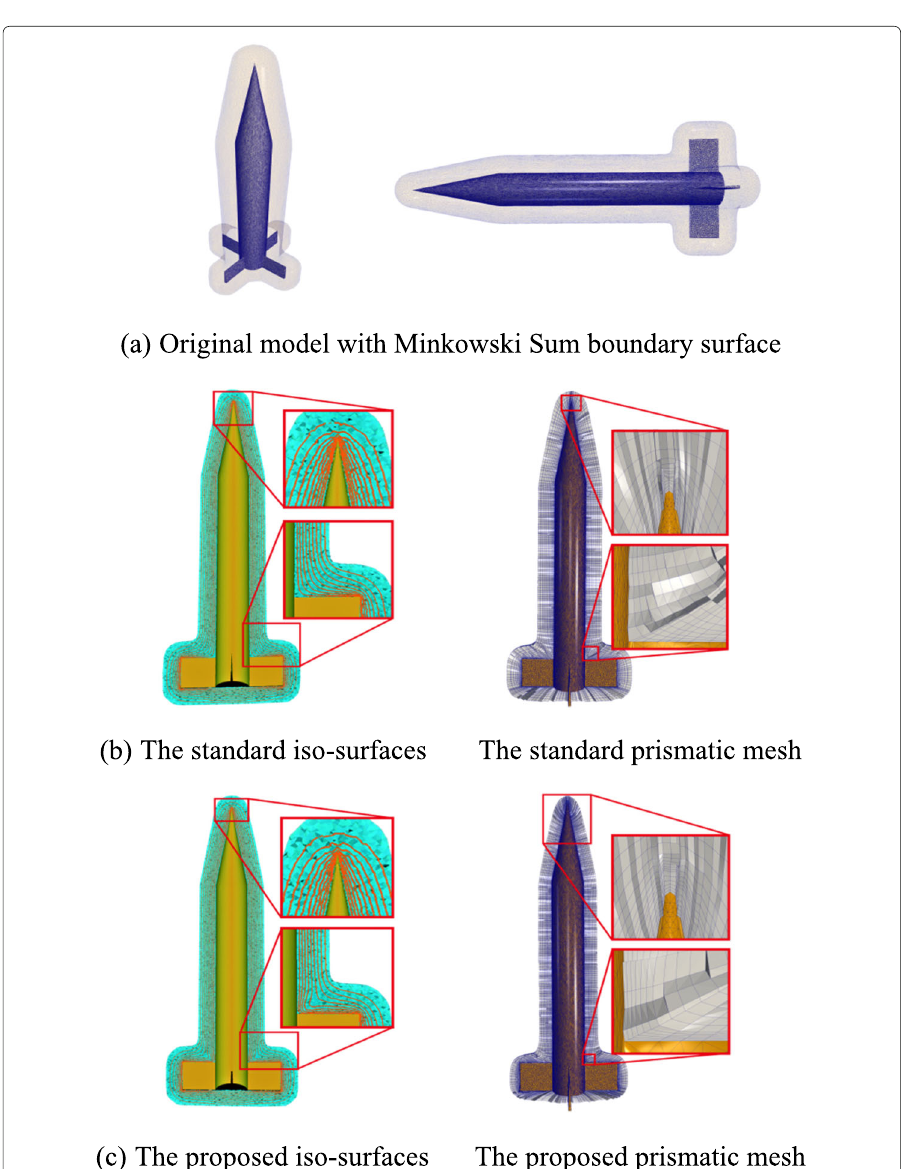
Fig. 5 Comparison of prismatic meshes. ( a ) The original surface and envelope surface; ( b ) and ( c ) The iso-surfaces and prismatic meshess generated using the standard harmonic field and the proposed anisotropic harmonic field,